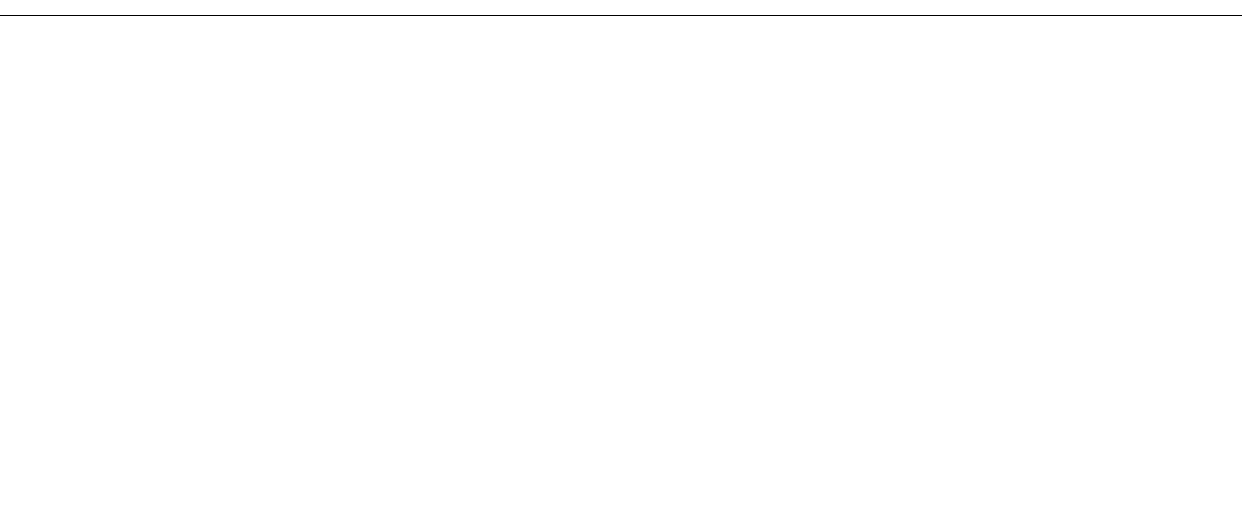
FIGUREA5 | Sequence of the conserved enhancer region in 20 vertebrate